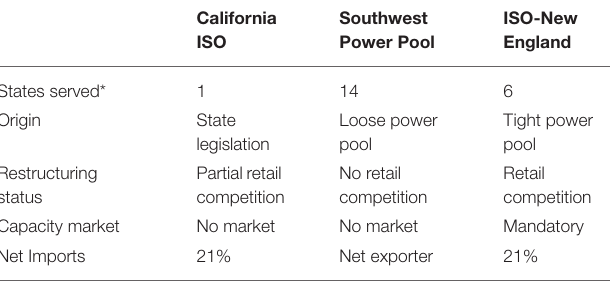
TABLE 1 | Comparison of context dimensions across selected regional transmission organizations.